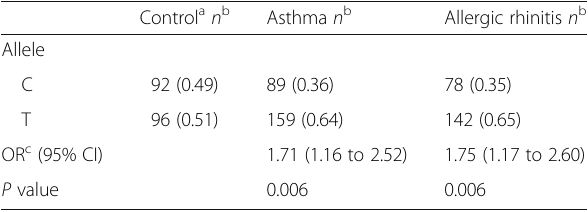
Table 3 Case – control allele data